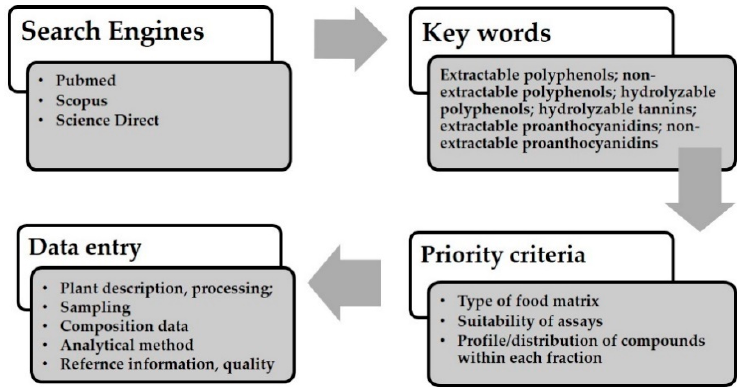
Figure 1. Flow diagram showing selection of studies for data entry.